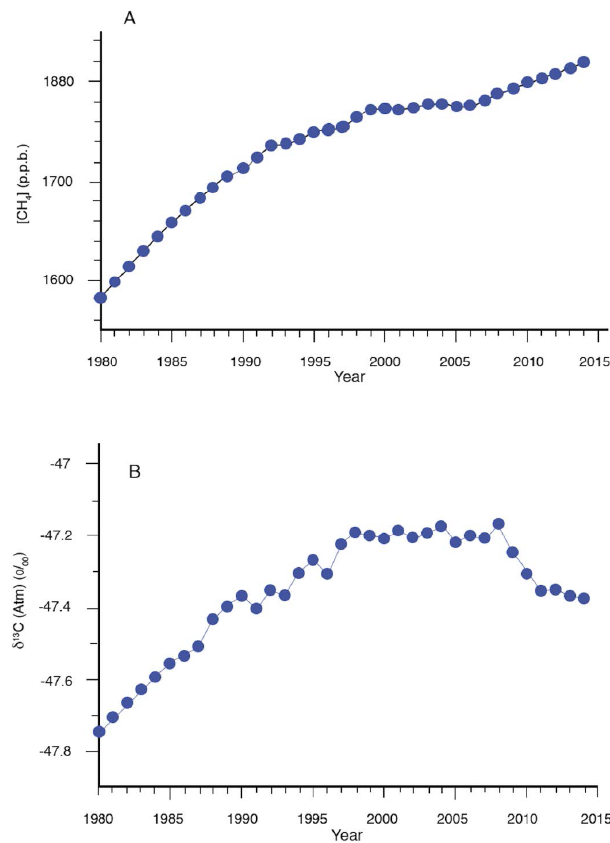
Figure 1. (a) Global increase in atmospheric methane between 1980 and 2015. (b) Change in δ 13 C value of atmospheric methane globally between 1980 and 2015. Both adapted from Schaefer et al.